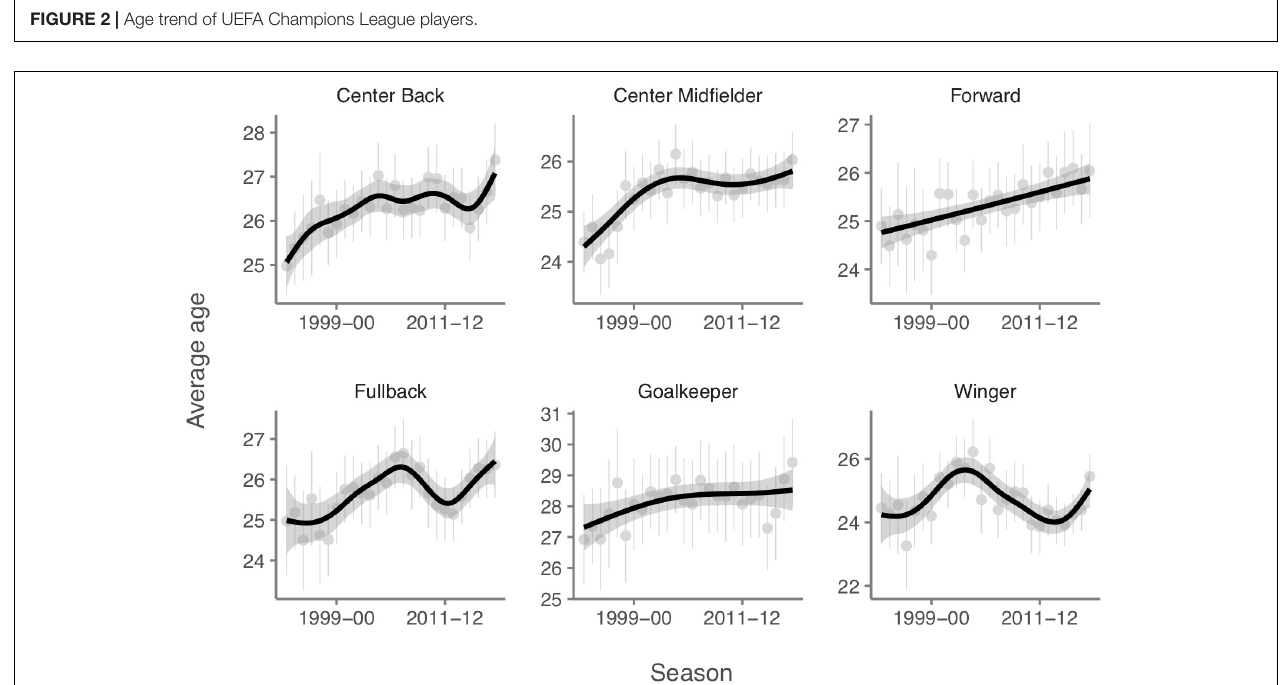
FIGURE 3 | Age trend by playing